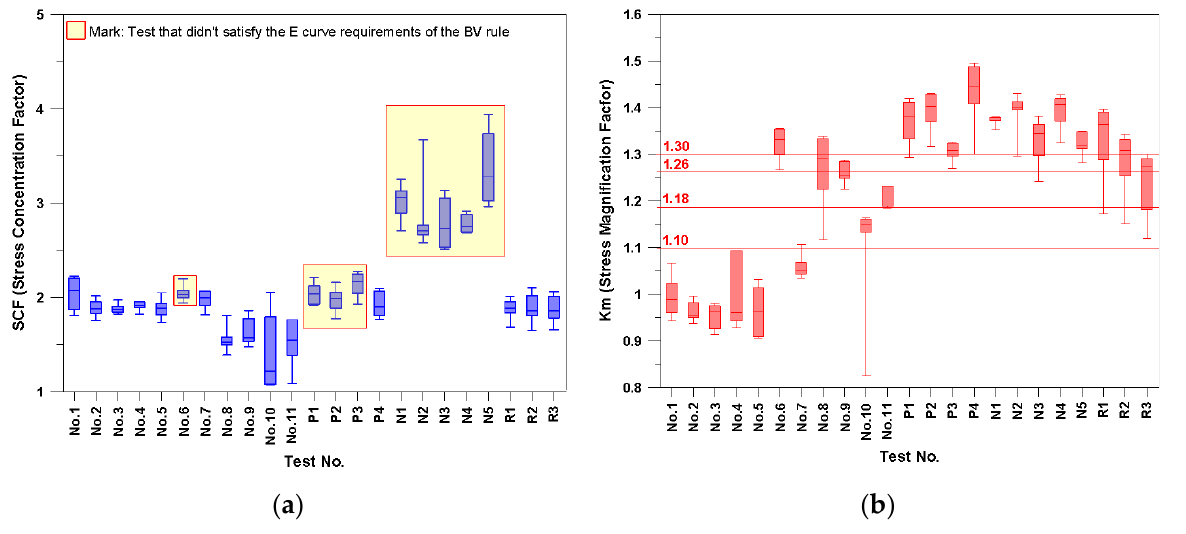
Figure 25. K (cid:2930) and K (cid:2923) at the fracture location for each test number: ( a ) K (cid:2930) ; ( b ) K (cid:2923) . Figure 25. K t and K m at the fracture location for each test number: ( a ) K t ; ( b ) K m . The combined stress concentration is expressed as a multiplication of K t and K m [30]. It was not possible to determine the border line for K